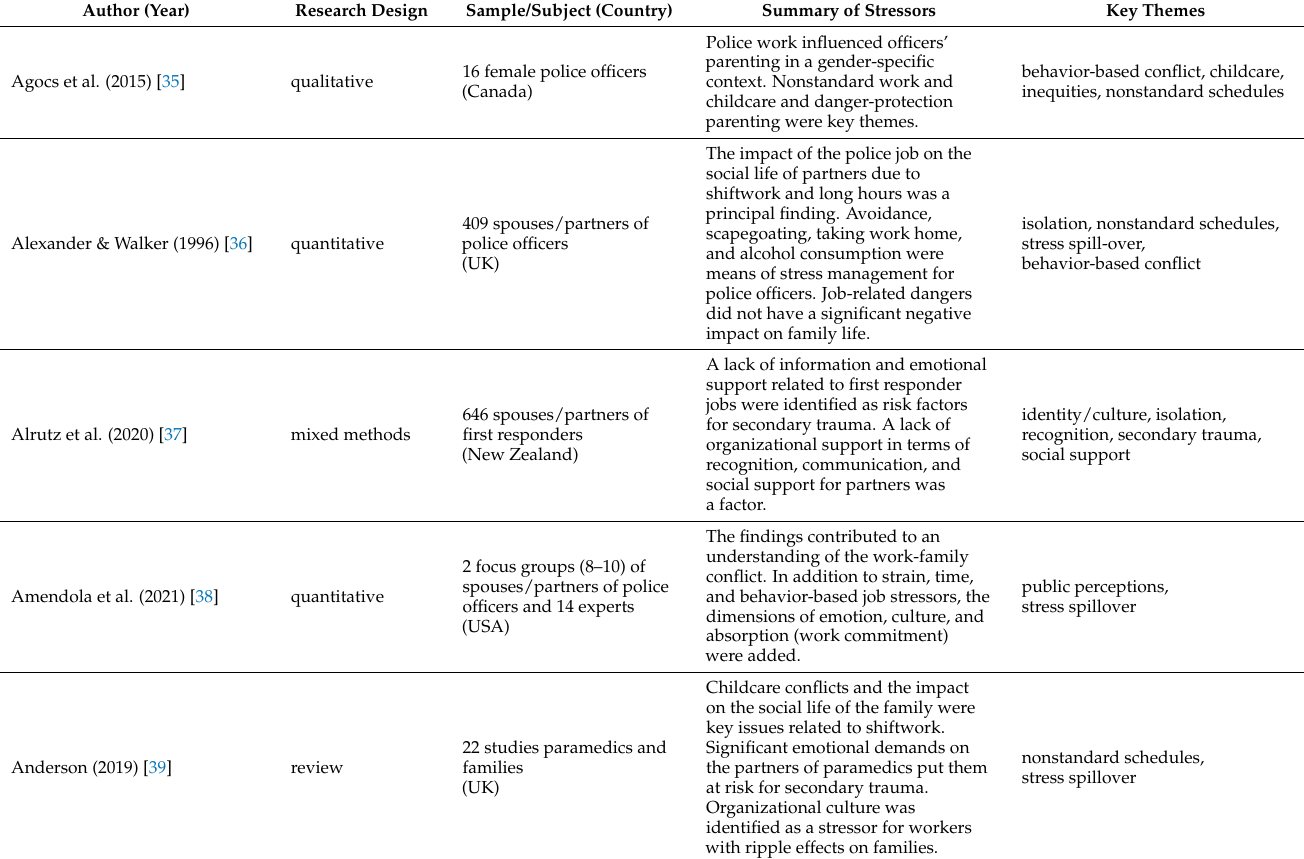
Table 1. Summary of articles included in the narrative